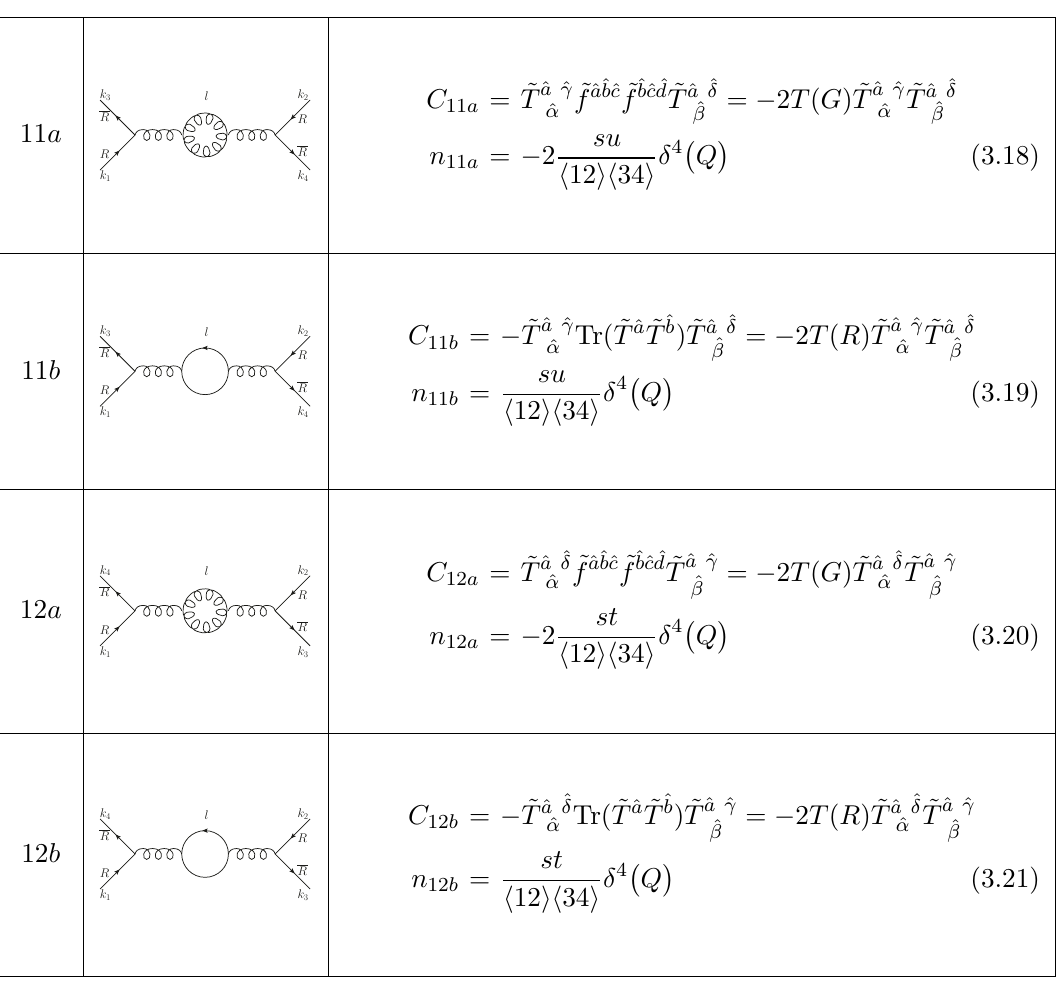
Table 2. Color and numerator factors for the 1-loop superamplitude with four external hyper- multiplets in case of a complex representation. Curly lines denote adjoint (cid:12)elds, while solid lines denote hypermultiplet matter (cid:12)elds. Arrows are assigned according to the representation and we use the short-hand notation (cid:14) 4